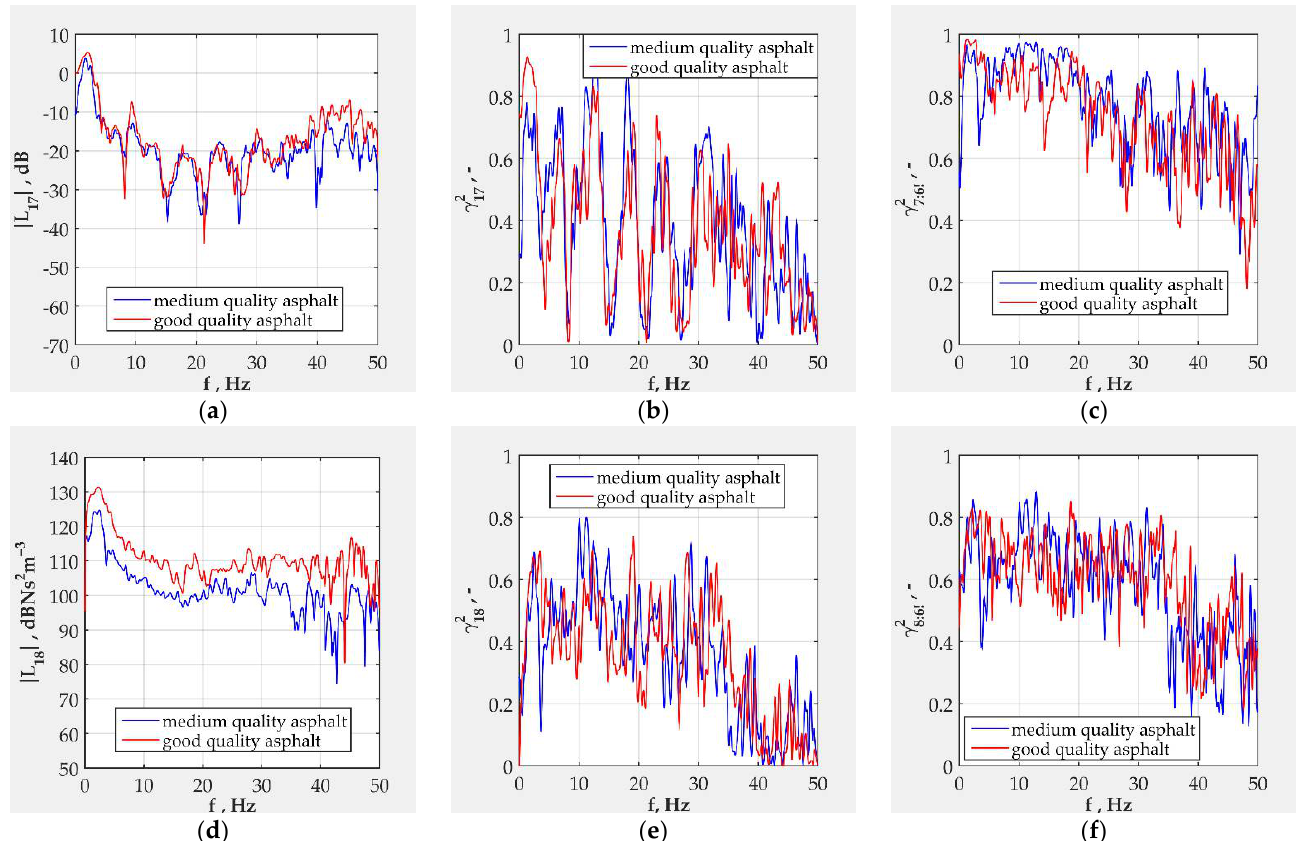
Figure 21. Effects of road quality on: ( a ) magnitude of frequency response function | L | ; ( b ) partial 17 coherence function γ 2 ; ( c ) multiple coherence function γ 2 ; ( d ) magnitude of frequency response 17 7:6! function | L 18 | ; ( e ) partial coherence function γ 2 ; ( f ) multiple coherence function γ 2 18 8:6!